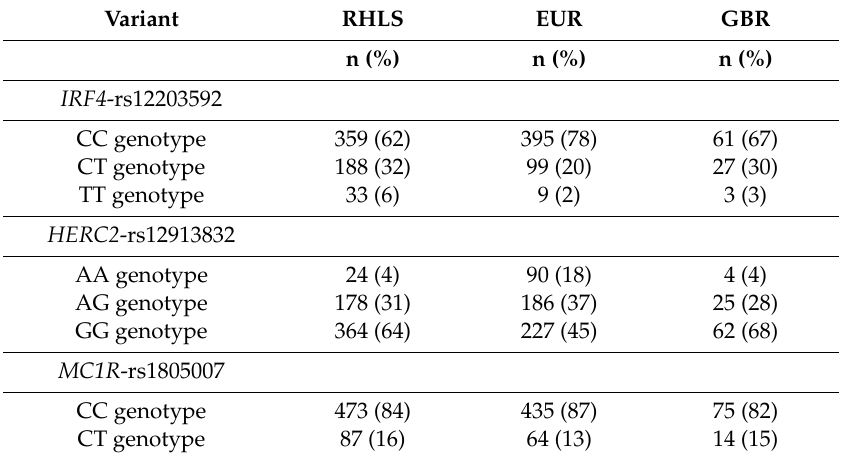
Table 3. Genotype frequencies for skin pigmentation variants in Retirement Health and Lifestyle Study (RHLS) cohort and comparison to 1000 Genomes European populations. Variant RHLS EUR GBR n (%) n (%)